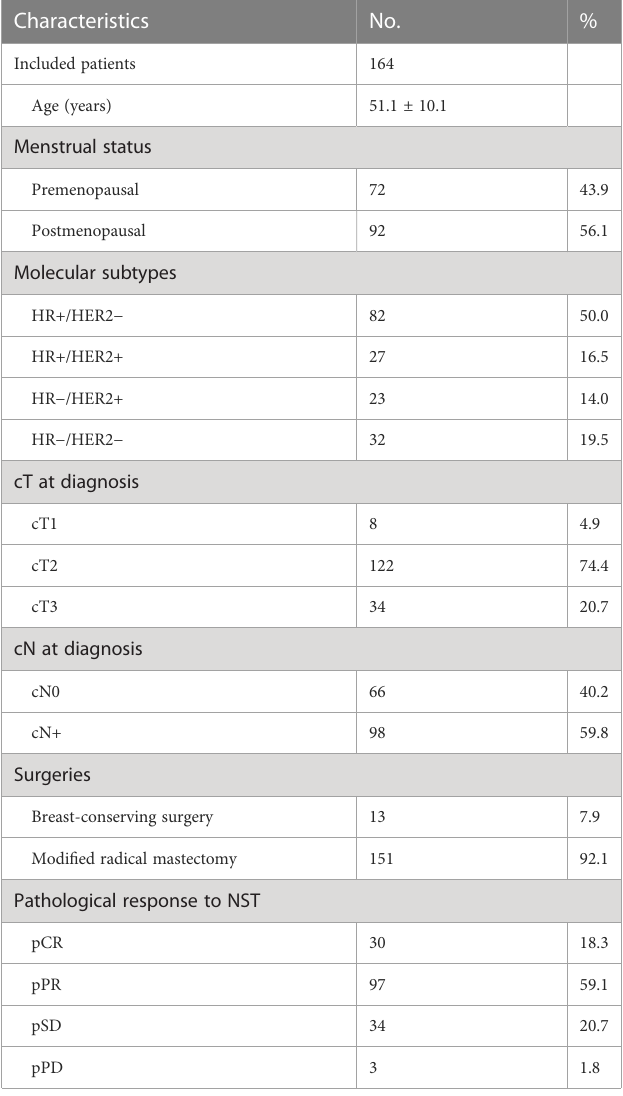
TABLE 1 Characteristics of included